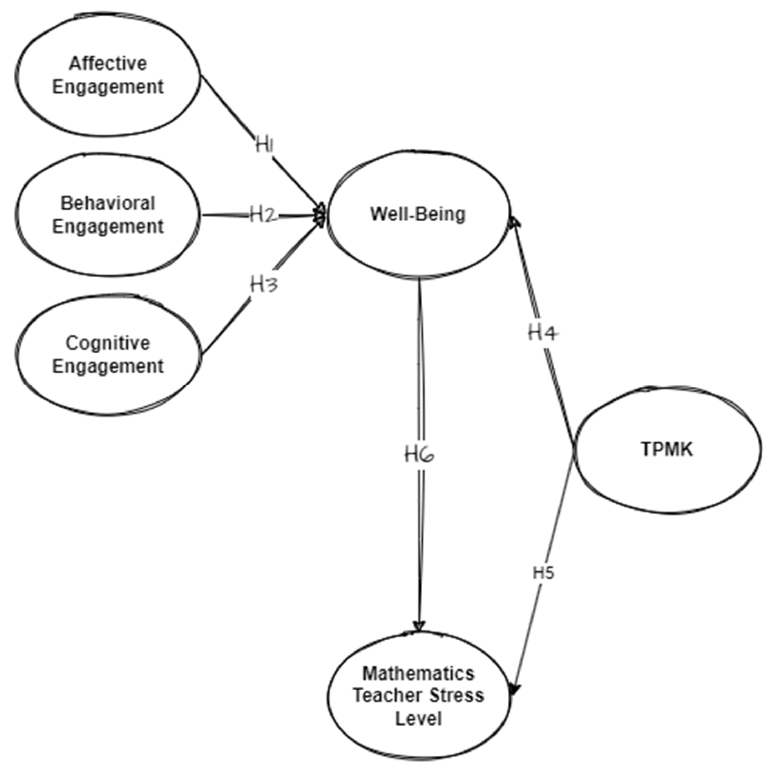
Figure 1. Study framework. Note: TPMK: Technological Pedagogical Mathematical Knowledge. Table 1. The initial hypotheses of factors associated with well-being and mathematics teachers’ stress levels.